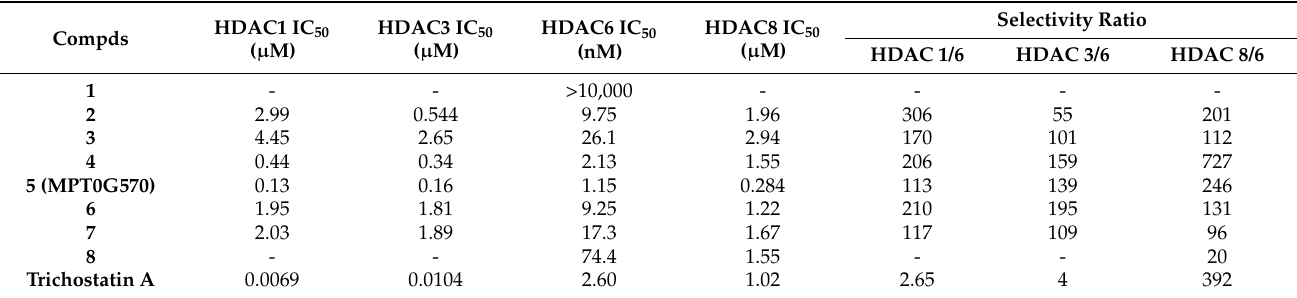
Table 2. HDAC isoform inhibitory effects of compounds 1 – 8